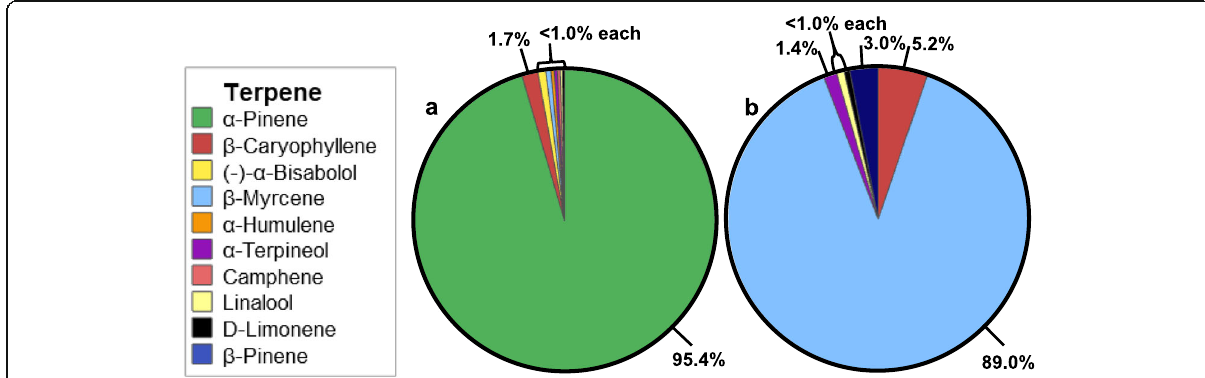
Fig. 2 Terpene profile of aged one-month DjG samples stored in the presence of α -pinene ( a ) and β -myrcene ( b ) “ isolates ”